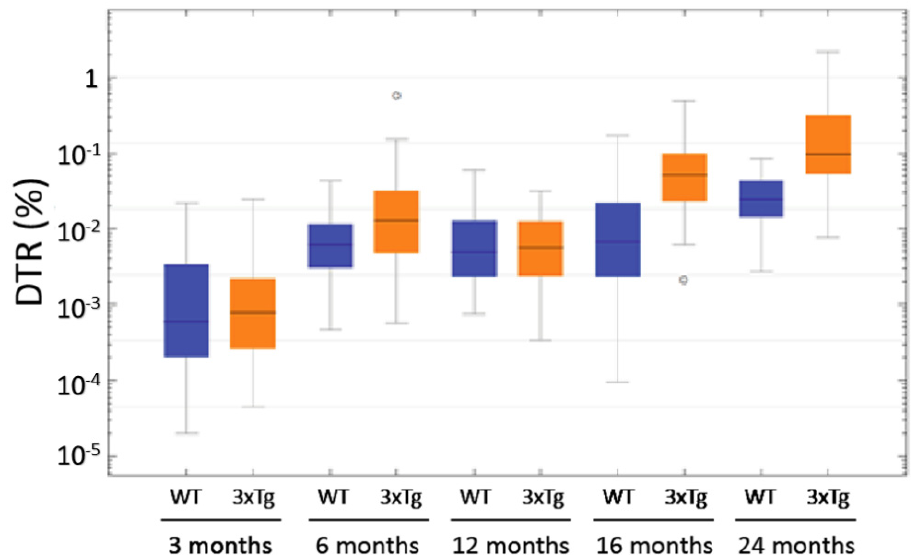
Figure 11. Logarithmically scaled box plot of the SP-G-immunopositive dot-to-tissue ratios (DTR) as a function of age and genotype. In the age groups of 3 and 12 month-old animals, there were no significant differences between 3xTg and WT mice (3 month-old: p = 0.897; 12 months-old: p = 0.971; Mann-Whitney-U Test). In the other age groups, a significant increase of the DTR in 3xTg mice when compared to their age-matched controls was evident (each p < 0.001 in the Mann-Whitney-U Test). Furthermore, this figure shows the increase in DTR over the course of ageing in both 3xTg- and WT- mice. ◦ : Indicates data values lying 1.5 to 3× of the IQR away from the mean value.